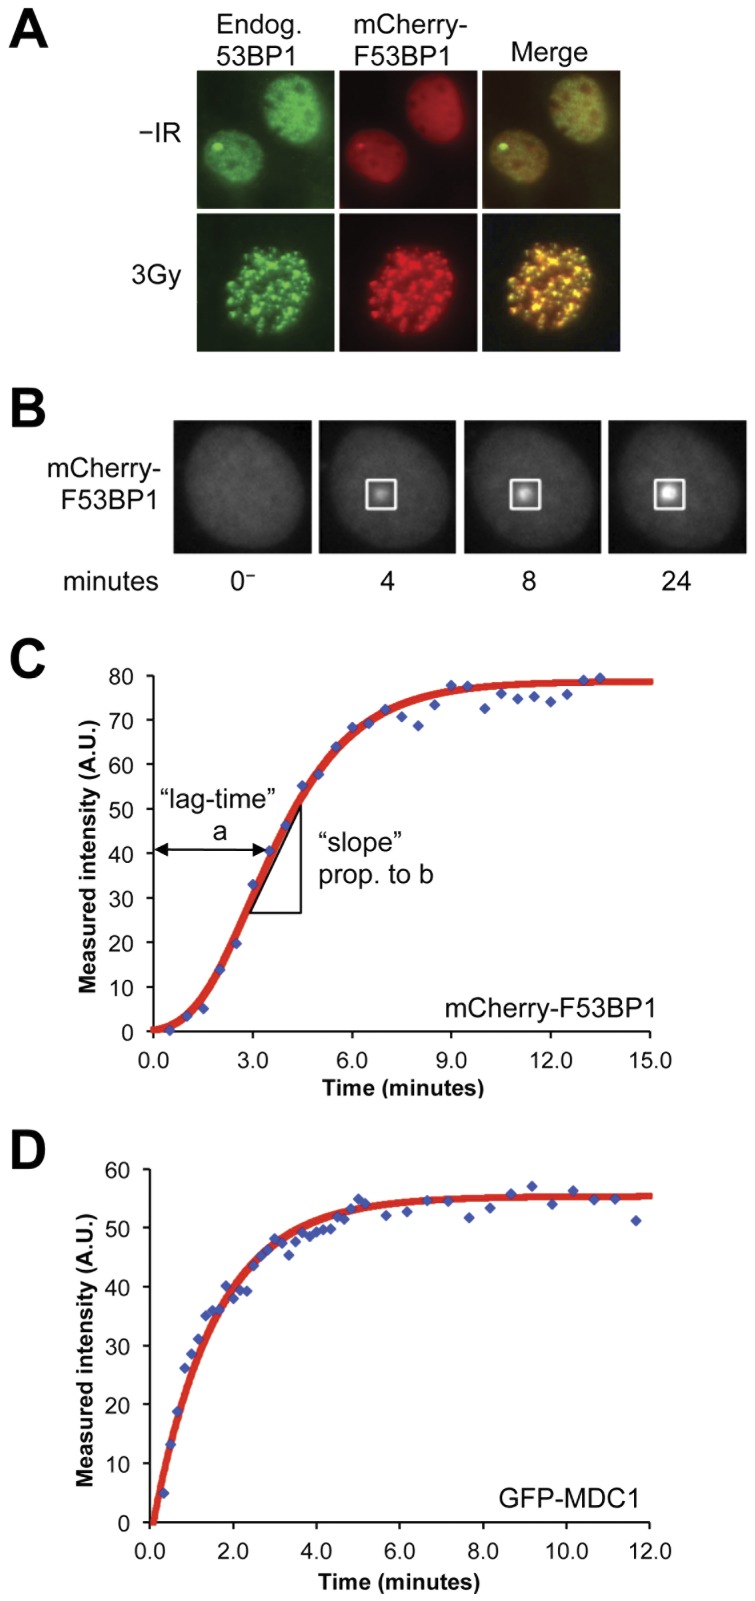
Recruitment of mCherry-F53BP1 to sites of damage induced by multi-photon laser.
A) Endogenous 53BP1 and mCherry-F53BP1 focus formation in wild type MEFs 30 minutes after 3 Gy IR treatment. B) Representative images of mCherry-F53BP1 accumulation over time at site of MPL-induced DNA damage. C) Plot of accumulation kinetics of mCherry-F53BP1 to MPL-induced damage demonstrates the lag in 53BP1 recruitment. Blue diamonds represent raw data, red line represents mathematical (Gompertz) model fit to raw data. The mathematical model allows the parameterization of different kinetic behaviors. The “lag-time” is the time it takes for protein recruitment to reach the inflection point of the curve, where the rate of change of the slope is equal to 0. The “slope” of the curve is measured at the inflection point. D) Plot of the accumulation of GFP-MDC1 to MPL-induced damage over time is well fitted by first order kinetics (red line).